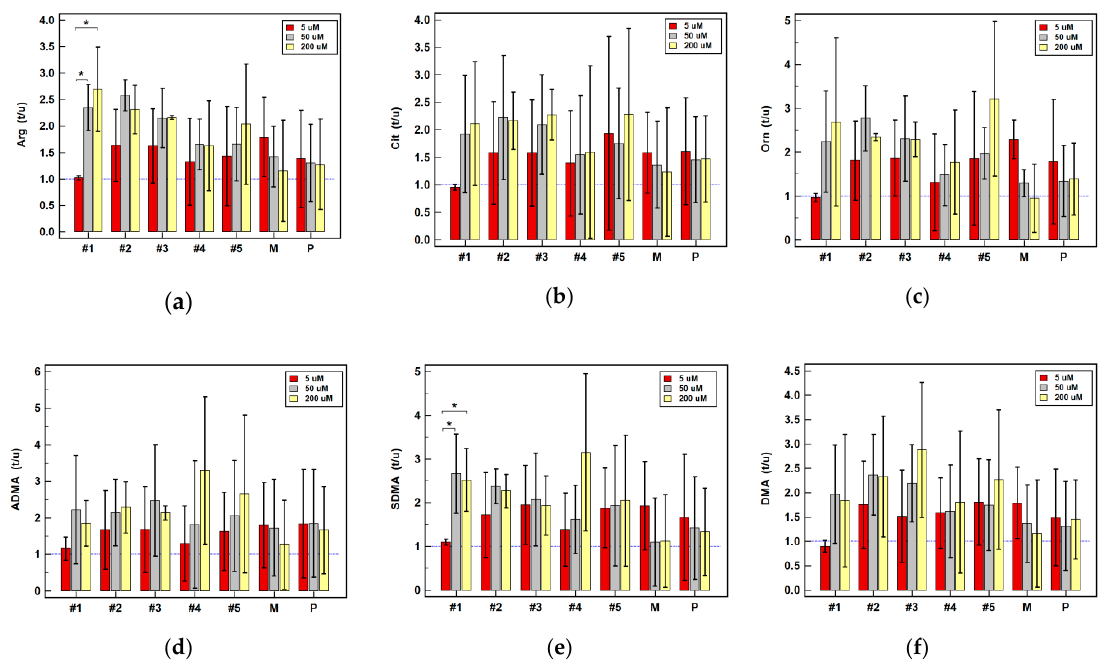
Figure 10. Dose-dependent effect of oxicams on the intracellular metabolite concentration in HCT 116 cells stimulated with 5, 50 and 200 µM drug concentrations for 24 h: ( a ) Arginine (Arg); ( b ) Citrulline (Cit); ( c ) Ornithine (Orn); ( d ) Asymmetric dimethylarginine (ADMA); ( e ) Symmetric dimethylarginine (SDMA); ( f ) Dimethylamine (DMA). Bars represent mean ( n = 3) concentration ratios treated-to-untreated cells (t/u) with standard deviation (whiskers). No effect is marked by horizontal blue reference line. Data were analyzed using one-way analysis of variance. *, significant between-group differences; #1 – 5, oxicam analogues; M, meloxicam; P, piroxicam.